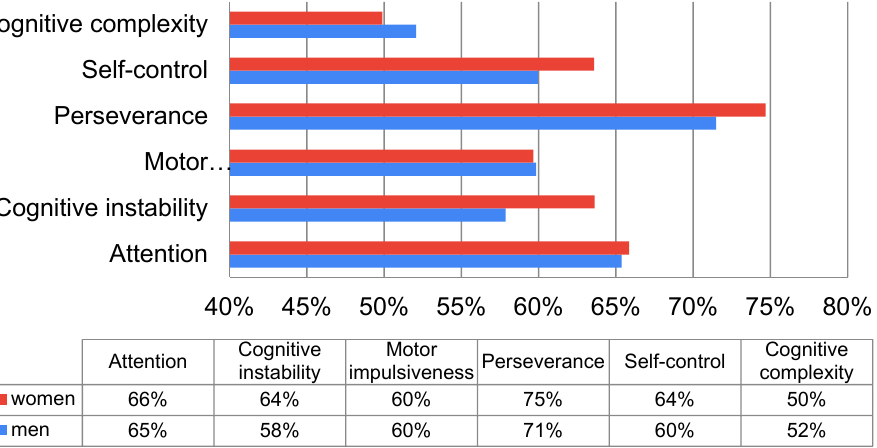
Figure 4. Average rating of Barratt Impulsive Scale (BIS-11) factors according to gender. Source: processed by authors.